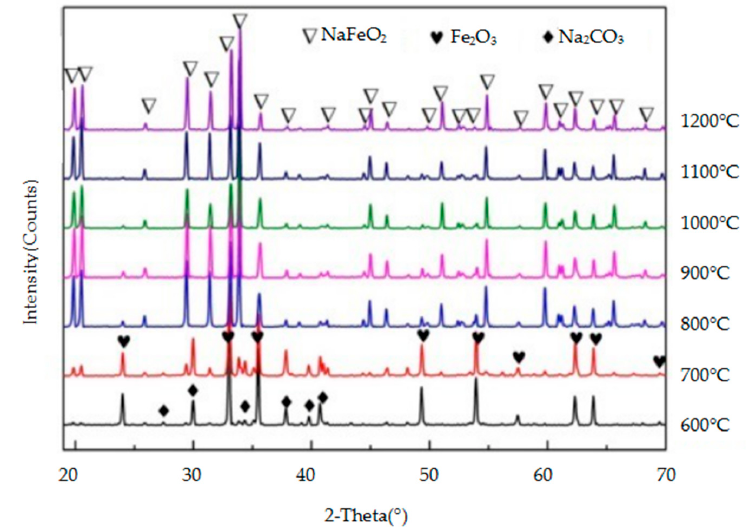
2 O 3 and Na 2 CO 3 .